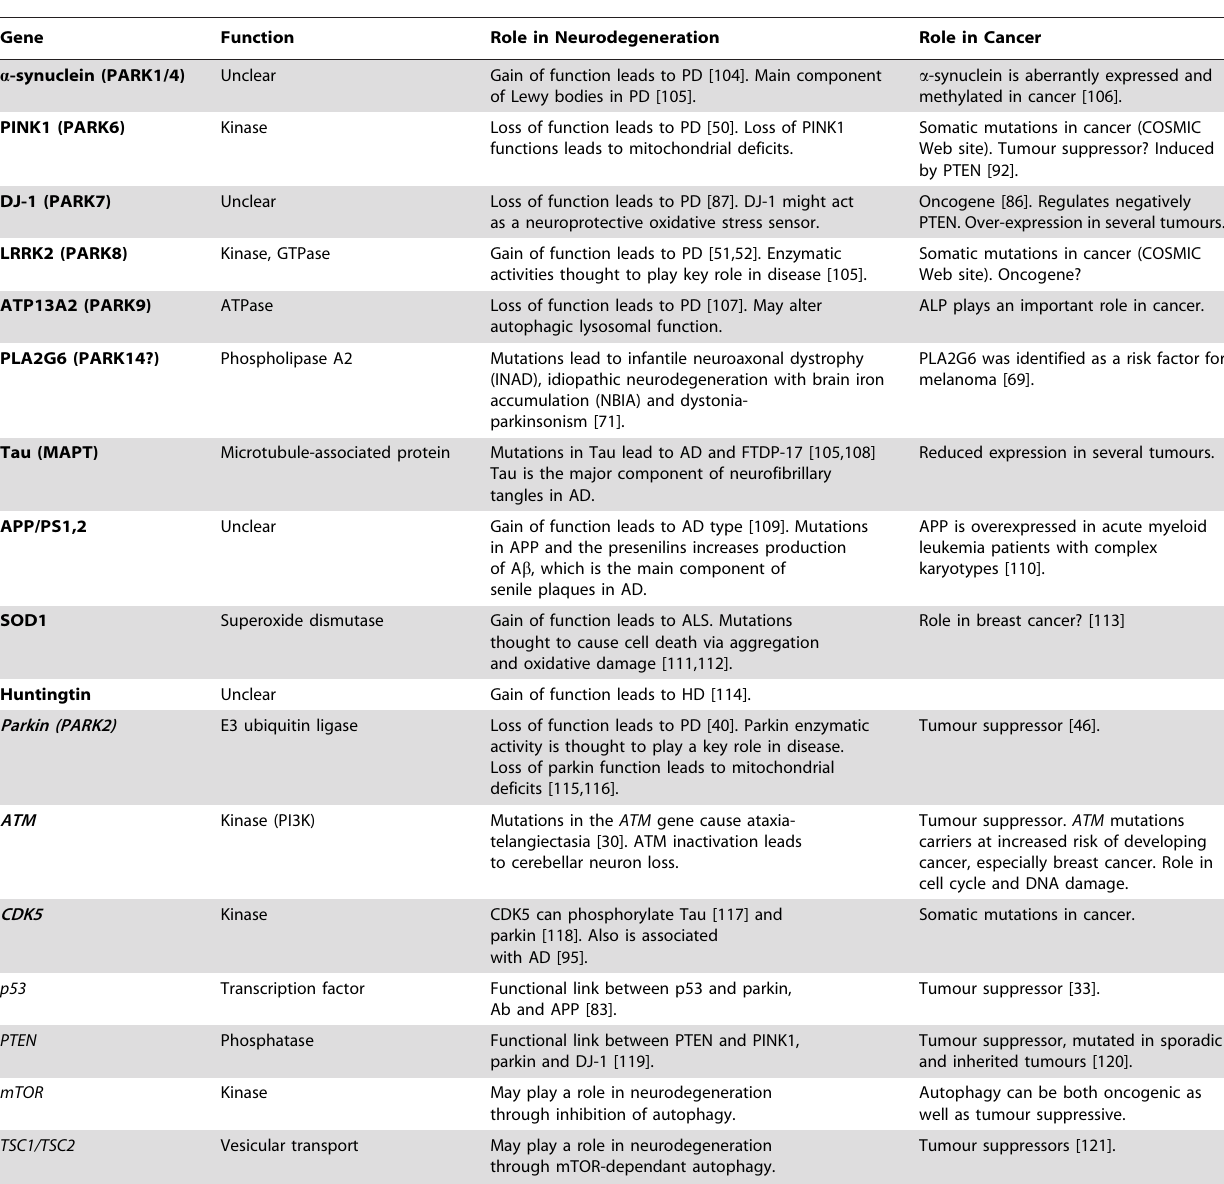
Table 1. Genetic determinants at the interface of cancer and